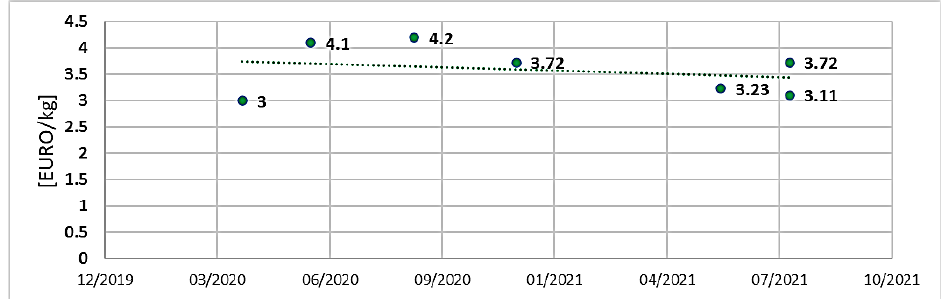
Figure 12. Operation cost for H 2